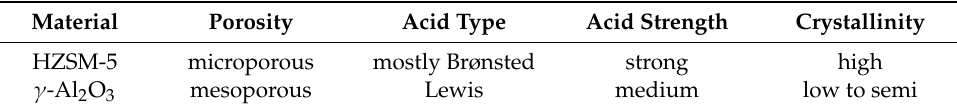
Table 1. Characteristic properties of HZSM-5 and γ -Al 2 O 3